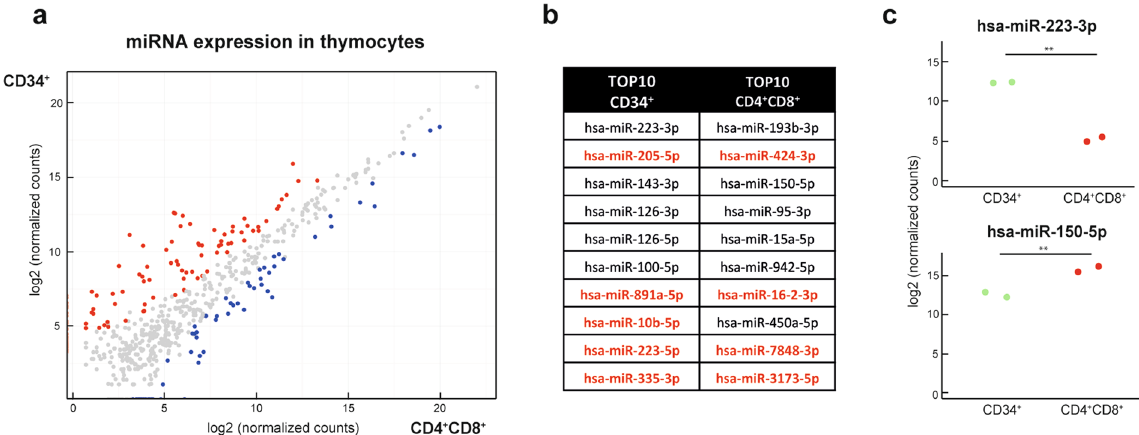
Figure 3. MiRNA profiling of healthy thymocyte subsets reveals different miRNA expression profiles between CD34 + and CD4 + CD8 + subsets. ( a ) Diagonal plot showing the expression of the miRNAs in the different thymocyte subsets. Red dots represent miRNAs that are significantly higher expressed in the CD34 + subset, blue dots are the miRNAs significantly higher expressed in the CD4 + CD8 + subset. ( b ) Top 10 most significantly upregulated miRNAs for the CD34 + subset and for the CD4 + CD8 + subset. MiRNAs denoted in red were not detected by a previously used qRT-PCR platform. ( c ) Dot plots of two representative miRNAs for the subsets. ** Significant difference with an adjusted p-value < 0.001.